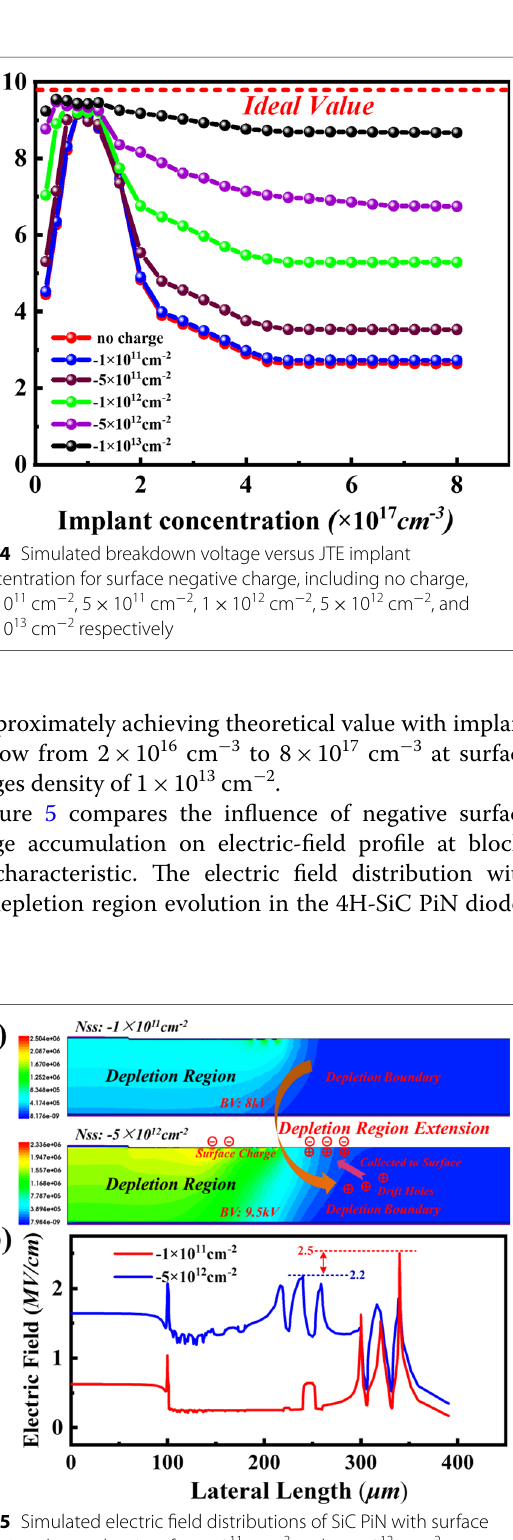
10 11 cm − 2 and 5 10 12 cm − 2 : a × × 10 16 cm − ×